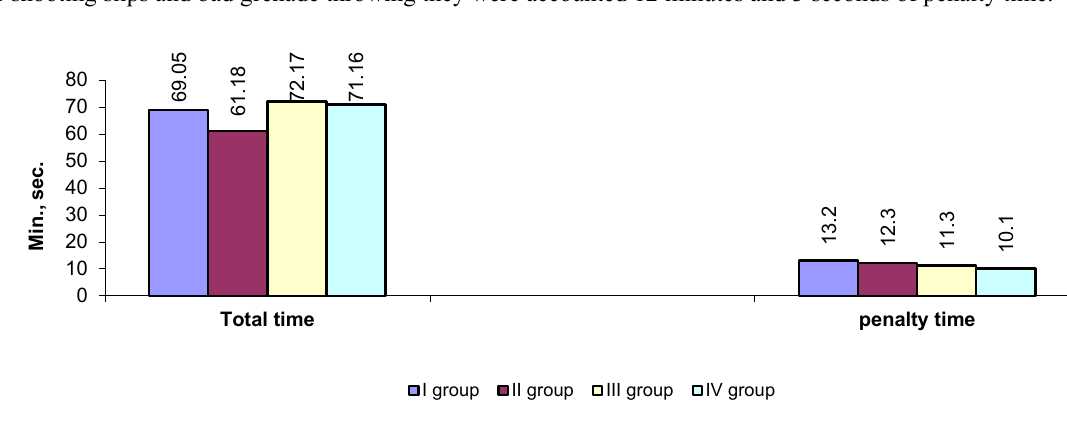
Fig. 2. Time indicators of sharpshooting and grenade throwing, demonstrated by cadets of different specialties, % Much worse picture was in group 1: lagging behind from cross leaders was 8 minutes. The fulfilled 87.5% hits and 12.5% successful grenade throwing. Thus, for shooting slips and unsuccessful grenade throwing they were accounted 13 minutes and 2 seconds of penalty